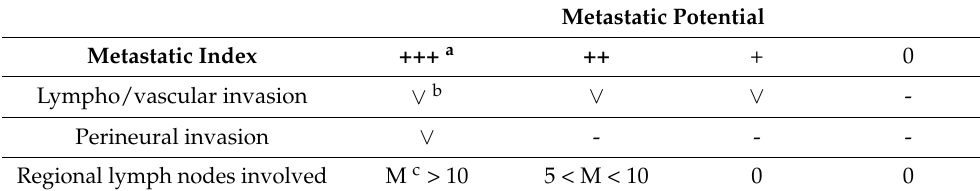
Table 1. Criteria for evaluation of Metastatic potential.